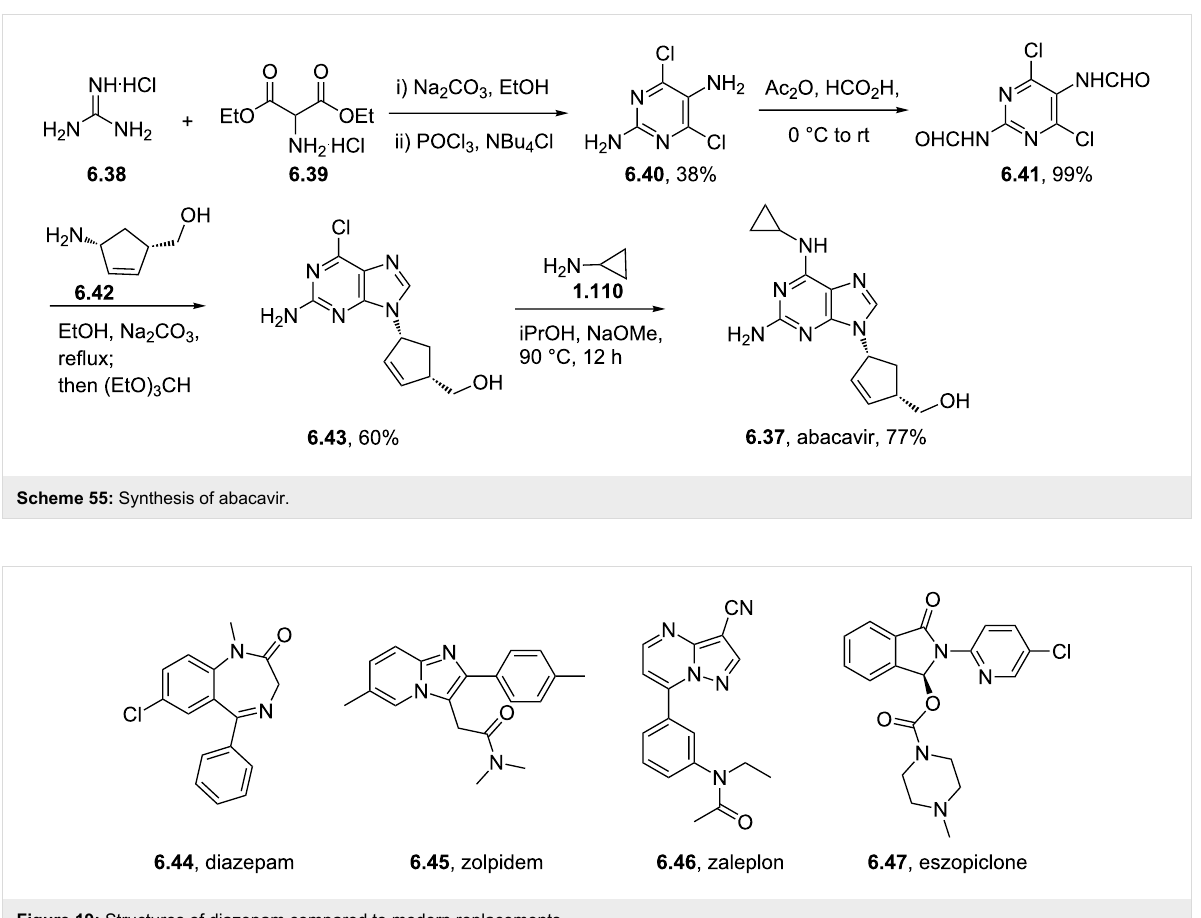
Figure 19: Structures of diazepam compared to modern